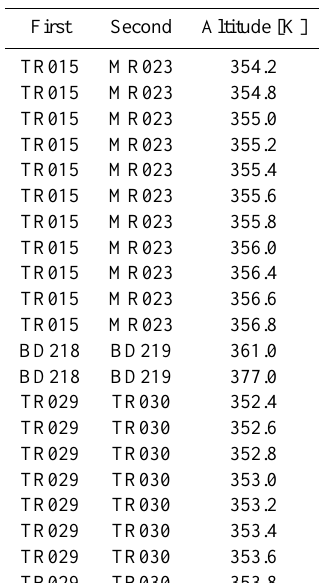
Table C1. List of all 107 matches. TR, MR, BD, HN, KT, and BI represent the sondes launched from Tarawa, R/V Mirai , Bandung, Ha Noi, Kototabang, and Biak,